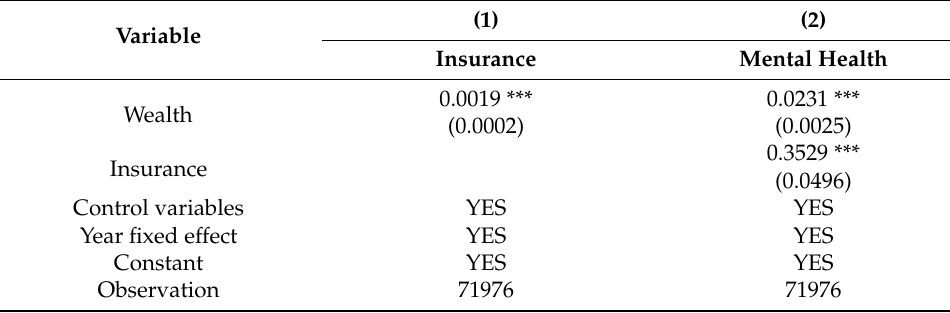
Table 7. Mediating effect of health insurance.